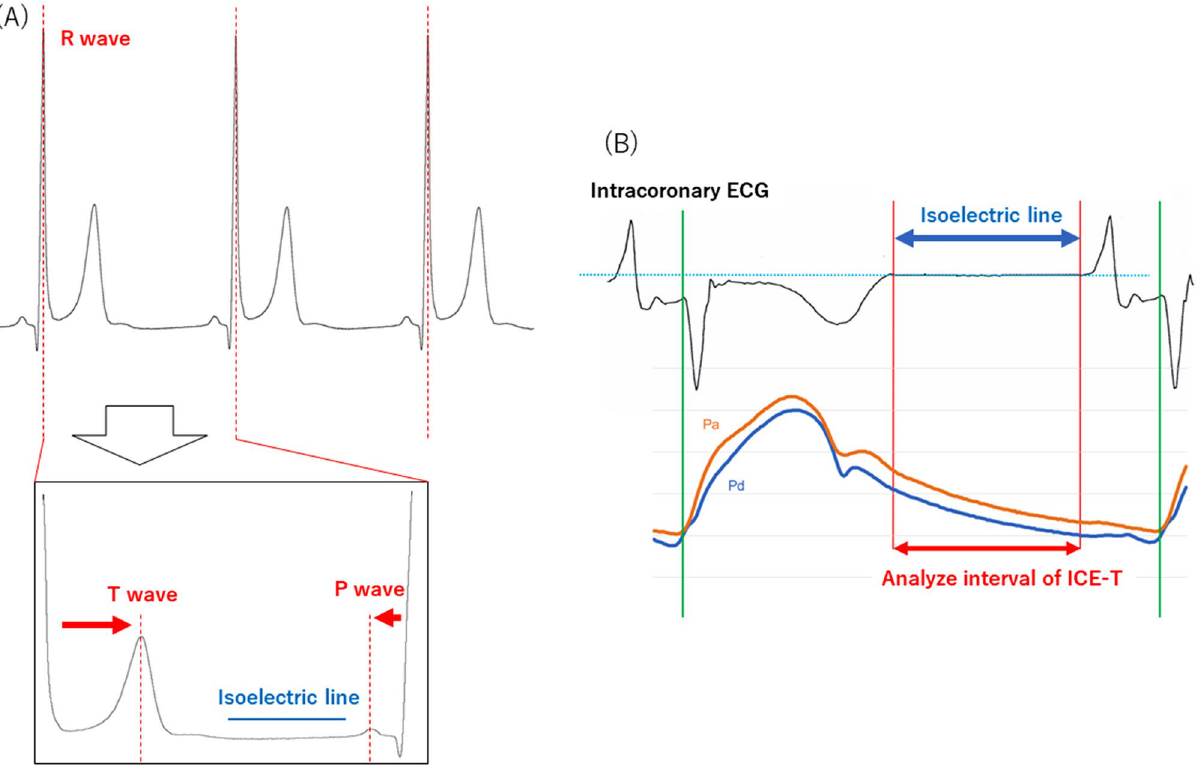
Figure 1. Calculation method for the intracoronary electrocardiogram-based pressure index. ( A ) The R wave was automatically detected and the cardiac cycle was identified. The slope of the intracoronary electrocardiogram, which was < 1 mV/mSec between T and P waves, was labeled as the isoelectric line. ( B ) First, the Q point of the intracoronary electrocardiogram (IC-ECG) was synchronized with the start points of the systolic phase in the pressure waveform. The IC-ECG-triggered distal/aortic pressure (Pd/Pa) ratio was defined as the average of Pd/Pa in the period corresponding to the isoelectric line.